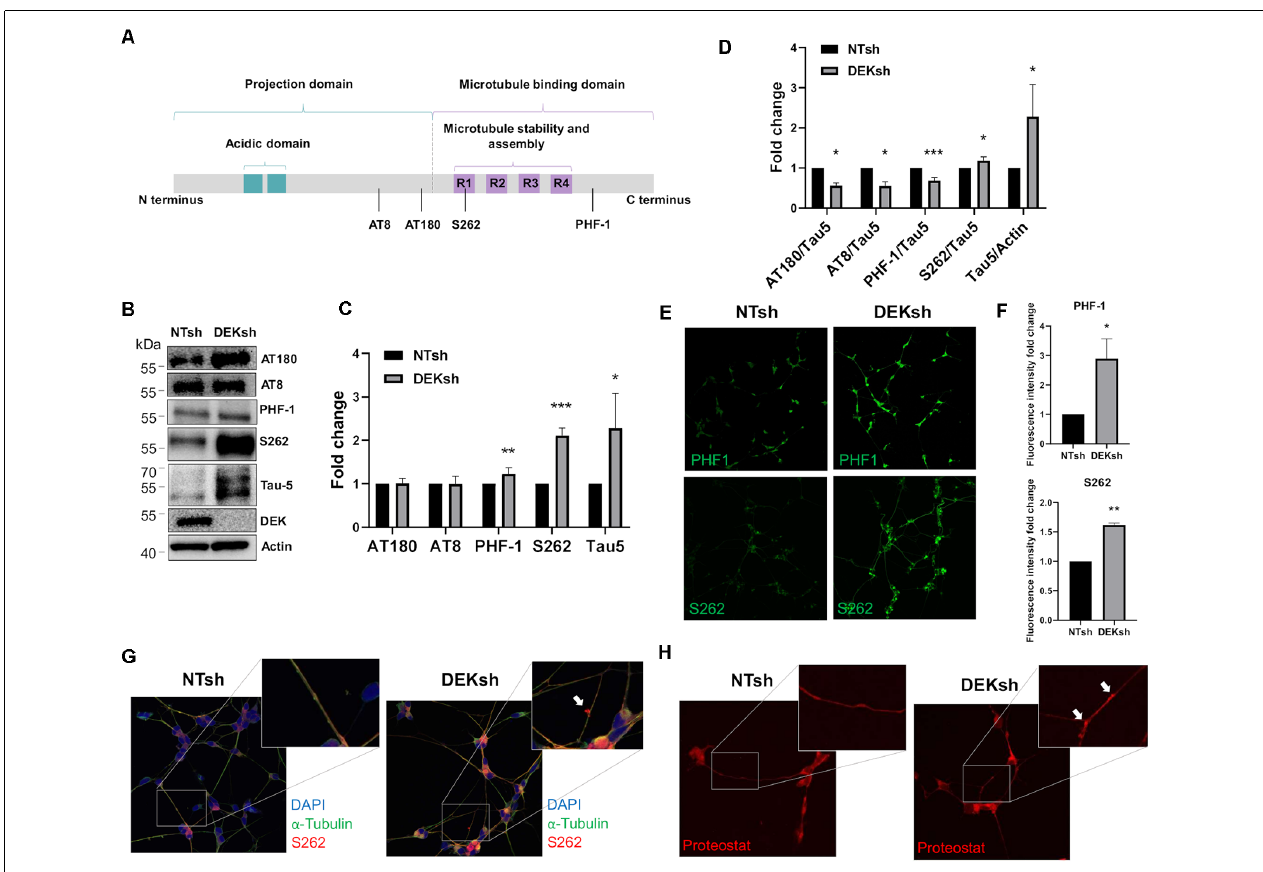
FIGURE 4 | DEK loss increases phosphorylation of Tau at sites within the microtubule-binding domain. (A) Representative figure of the longest isoform of Tau (2N4R). The four phosphorylation sites of interest are indicated by a black line. (B,C) Western blotting reveals a significant increase in phosphorylated Tau at PHF-1 and S262 in DEKsh cells (* p < 0.05; ** p < 0.01; *** p < 0.001). (D) When normalized to total Tau (Tau-5) expression levels by western blot (B) , S262 was abnormally phosphorylated after DEK knockdown, while Tau at sites AT180, AT8, and PHF-1 were not hyperphosphorylated relative to total Tau (* p < 0.05; ** p < 0.01; *** p < 0.001). (E,F) Phosphorylation at sites PHF-1 and S262 is increased in DEKsh cells relative to NTsh cells, quantified by fluorescent intensity (* p < 0.05; ** p < 0.01). (G) Aggregates of S262-phosphorylated Tau are found in the neurites of DEKsh cells, but not in NTsh cells. (H) Protein aggregates are observed